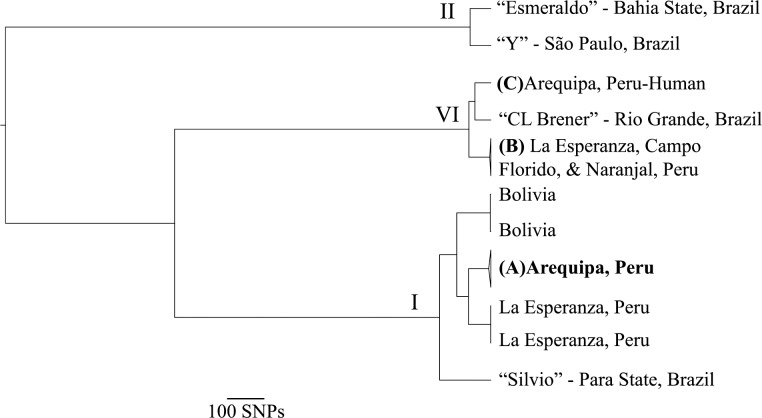
The extant T. cruzi population in Arequipa arose from a single, recent introduction.Maximum clade credibility (MCC) tree shows that (A) all 123 T. cruzi isolated from bugs and domestic mammals in Arequipa form a monophyletic group with a single, recent common ancestor, indicative of a single immigration event in the recent past. Despite substantial genetic diversity among T. cruzi throughout South America, those collected in Arequipa show little diversity. (B) Three samples collected in Campo Florido and Naranjal, Peru and one sample from La Esperanza, Peru have nearly identical maxicircle sequences and form a monophyletic group. La Esperanza, Peru contains at least two distinct T. cruzi lineages, suggesting multiple independent introductions. (C) The only T. cruzi sample isolated from a human in Arequipa is distinct from all other samples from Arequipa, suggesting that this introduction has not established in the city. All tips represent a single sample except (A) (N = 123) and (B) (N = 4). All nodes have strong support (posterior probability≥0.99). Nodes are collapsed when the samples contained have nearly identical maxicircle sequences. Roman numerals signify DTU.